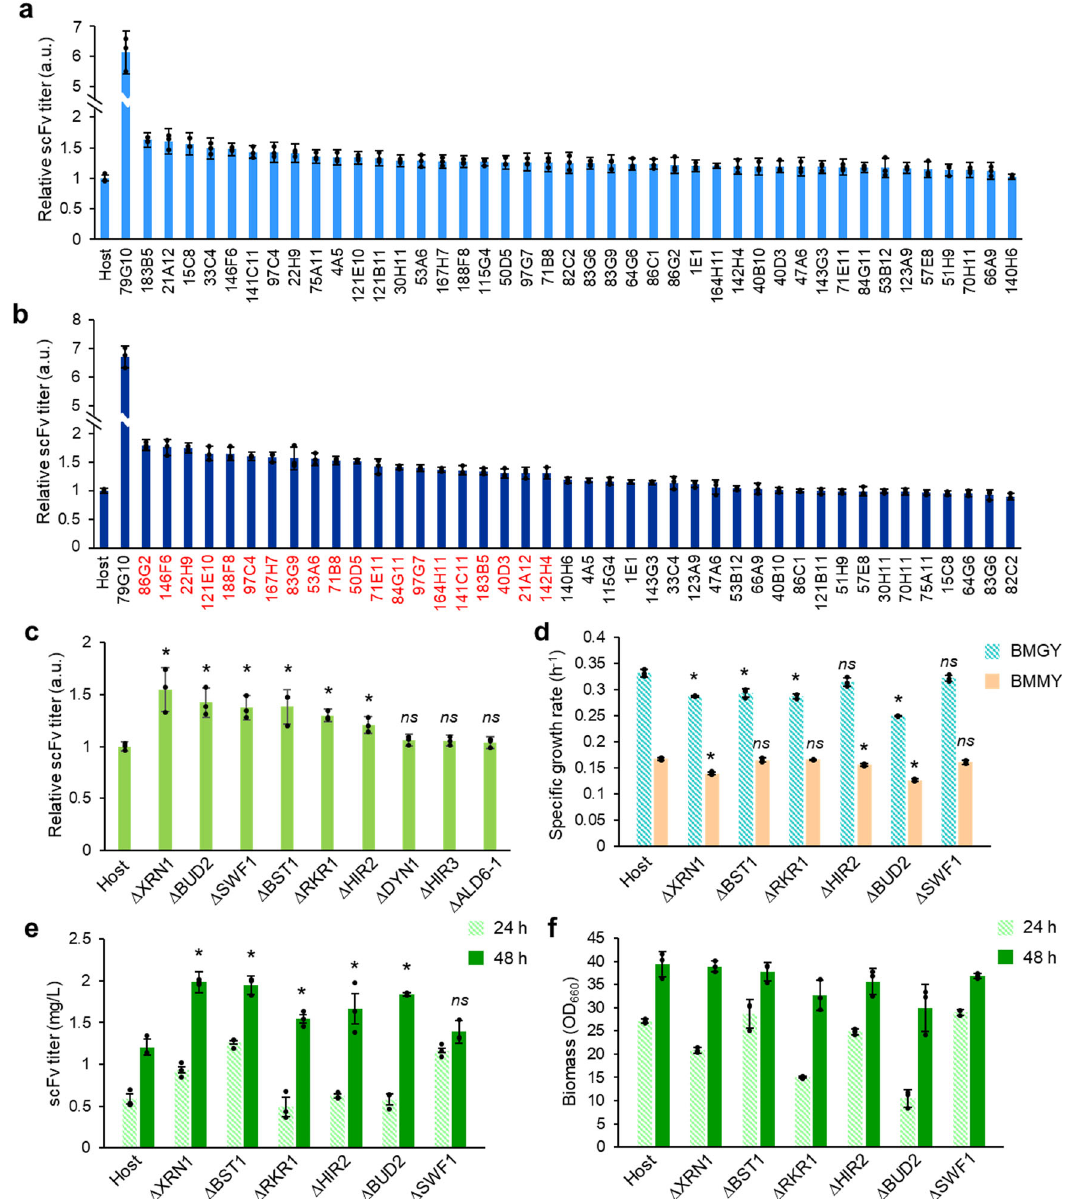
Fig. 2 The scFv antibody titers from screening-positive clones. Relative titers of REMI-based screening positives cultured in 96-deep-well plates ( a ) or test tubes ( b ). A total of 43 positive strains were chosen from the REMI-based screen ( a ) and for re-evaluation ( b ) on the wild-type K. phaf fi i strain. A single highly positive and many weakly positive clones were obtained. The top 20 clones with higher protein secretion performance in test tube cultivation (1.3-times higher than the host strain) were labeled in red (except for 79G10, in which a mutation in the MF α secretion signal peptide contributed to the scFv secretion performance) ( b ). After identifying the plasmid integration locus for the 20 strains, nine unique gene disruptions were identi fi ed. The titer values of screening positives were normalized to that of the host strain. Error bars represent standard deviations from three technical replicates ( c ). Relative titers of test tube cultivations for dnl4his4 – based re-construction strains at 60 h after methanol induction. Among the nine reconstructed strains, six gene-disrupted strains showed higher titers than the host strain with signi fi cant difference, indicating that six gene-disruption-type effective factors were identi fi ed. d Growth rate analysis of the six gene-disrupted strains and the host strain on BMGY (emerald, diagonal stripes) and BMMY (orange, fi lled bars) are indicated. e , f The re-constructed gene-disruption and the host strains were cultivated in the shake fl asks. The titer ( e ) and fi nal OD 660 values ( f ) of each strain at 24 h (light green, diagonal stripes) and 48 h (dark green, fi lled bars) sampling points after methanol induction are indicated. Error bars represent standard deviations from three biological replicates. Asterisks and “ ns ” indicate the signi fi cance level ( p < 0.05 by t -test) and non-signi fi cance level ( p > 0.05 by t -test) between the host and effective factor-disruption strains, genome cutting before self-ligation to obtain a plasmid comprised isolate the plasmid. From sequence analysis of the genomic of genome-integrated REMI fragment and fl anking chromosomal fragments fl anking the pREMI-ZA sequences of the self-ligated region 19 . In this experiment, however, we used eight restriction plasmids, we were able to identify the genome insertion locus for enzymes (all absent from pREMI-ZA) to generate short fragments 18 of 20 positives, and these comprised 13 unique gene of yeast genomic DNA. This allowed us to easily and ef fi ciently disruptions (Table 1).